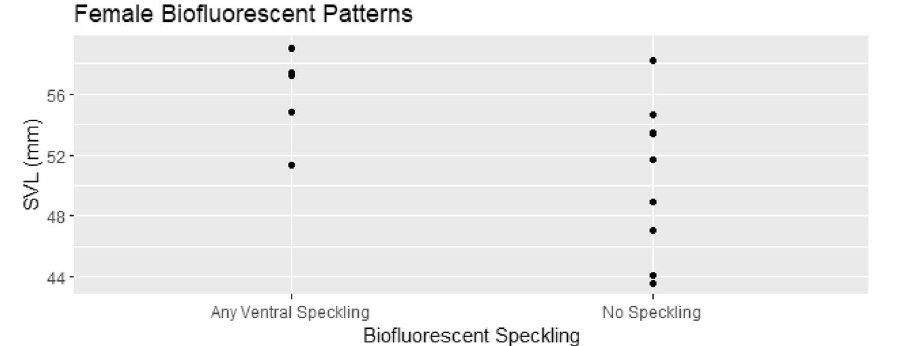
Figure 5. Scatter plot of female biofluorescent speckling with snout-vent